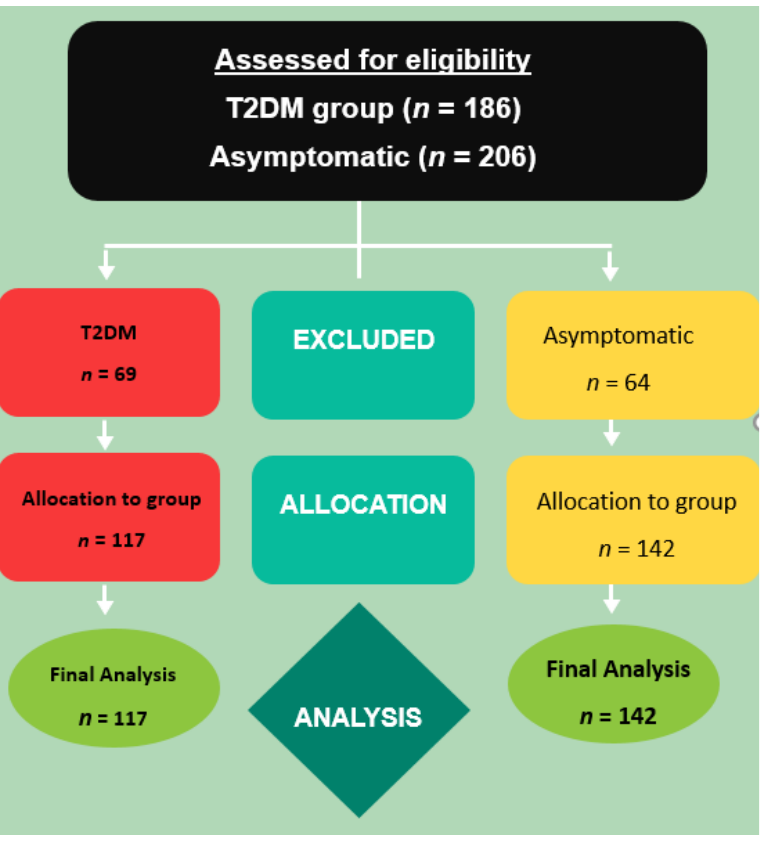
Figure 2. CONSORT flow diagram of the cross-sectional study.